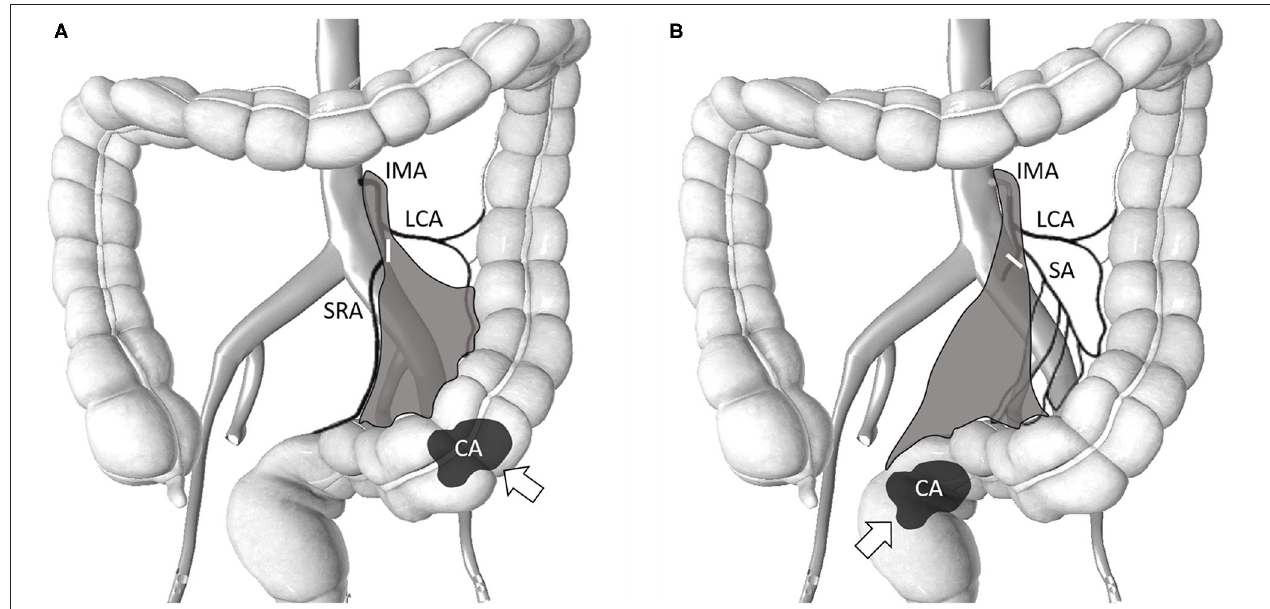
FIGURE 1 | Schematic of the area (gray-color) of lymph node clearance in high dissection and selective ligation. The origin of the IMA from the abdominal aorta and the junction of the IMA and LCA was explored. Lymphoadipose tissues around this area were skeletonized and stripped to facilitate complete D3 lymph node dissection. The short white bar denotes the level of the major feeding vessel ligated and transected. (A) Selective ligation of the SA with preservation of the LCA for sigmoid colon cancer. The SRA was also preserved during AR when the tumor was located in the proximal sigmoid colon; (B) Selective ligation of the SRA with preservation of the LCA for rectal cancer. The SA was also preserved in case of rectal cancer with redundant sigmoid colon. IMA, inferior mesenteric artery; LCA, left colic artery; SA, sigmoid artery; SRA, superior rectal artery; AR, anterior resection; CA and arrow denotes the tumor